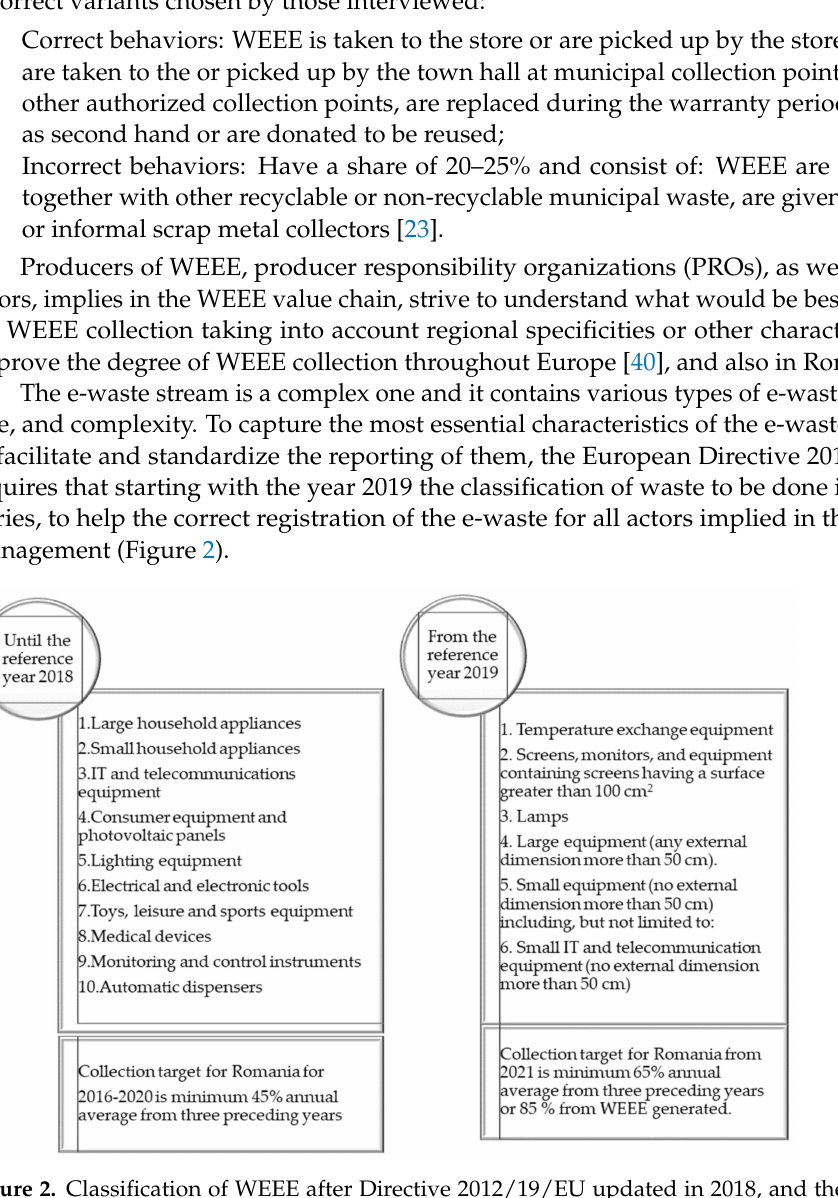
Figure 2. Classification of WEEE after Directive 2012/19/EU updated in 2018, and the collection target of WEEE for